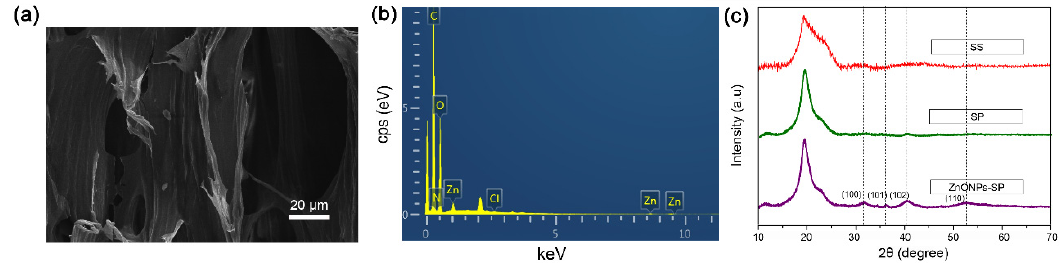
Figure 3. SEM, EDS and XRD. ( a ) Field emission scanning electron microscope image of ZnONPs-SP, ( b ) EDS spectrum of ZnONPs-SP, ( c ) XRD profiles of sericin, SP, and ZnONPs-SP sponge.